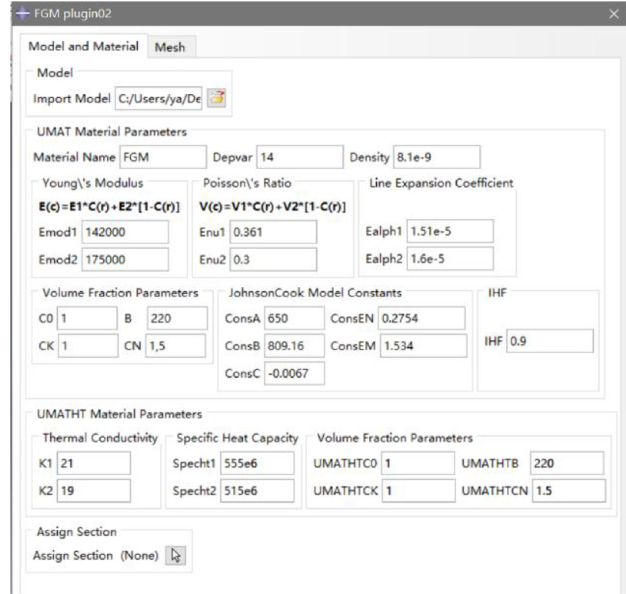
Fig. 3. Setting interface of functionally graded material (FGM)